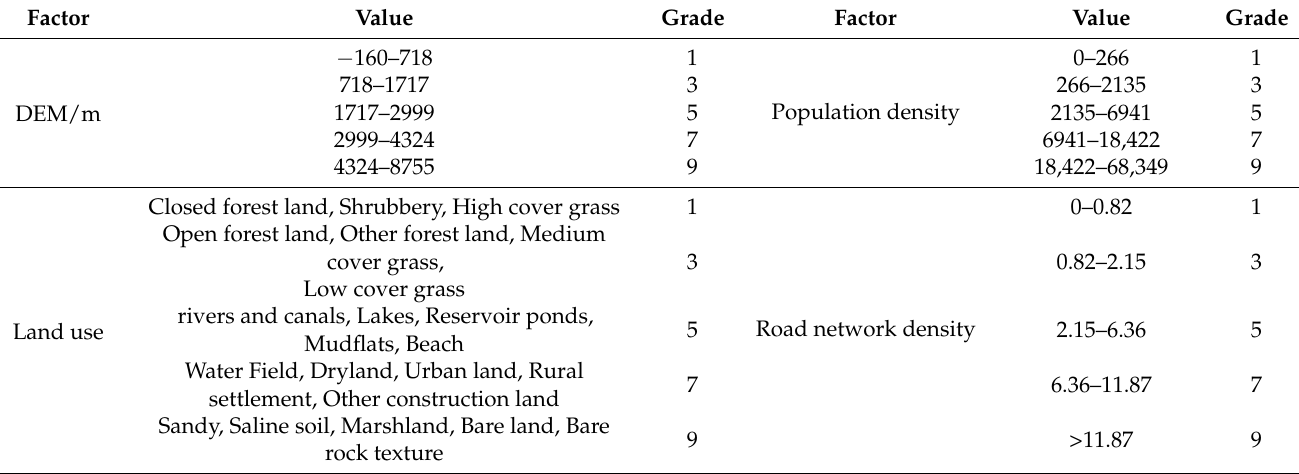
Figure 3. Results of factors for constructing ecospatial networks. (The meaning of land use 1, 3, 5, 7, 9 expressions are shown in Table 2). Table 2. Ecological resistance factor evaluation